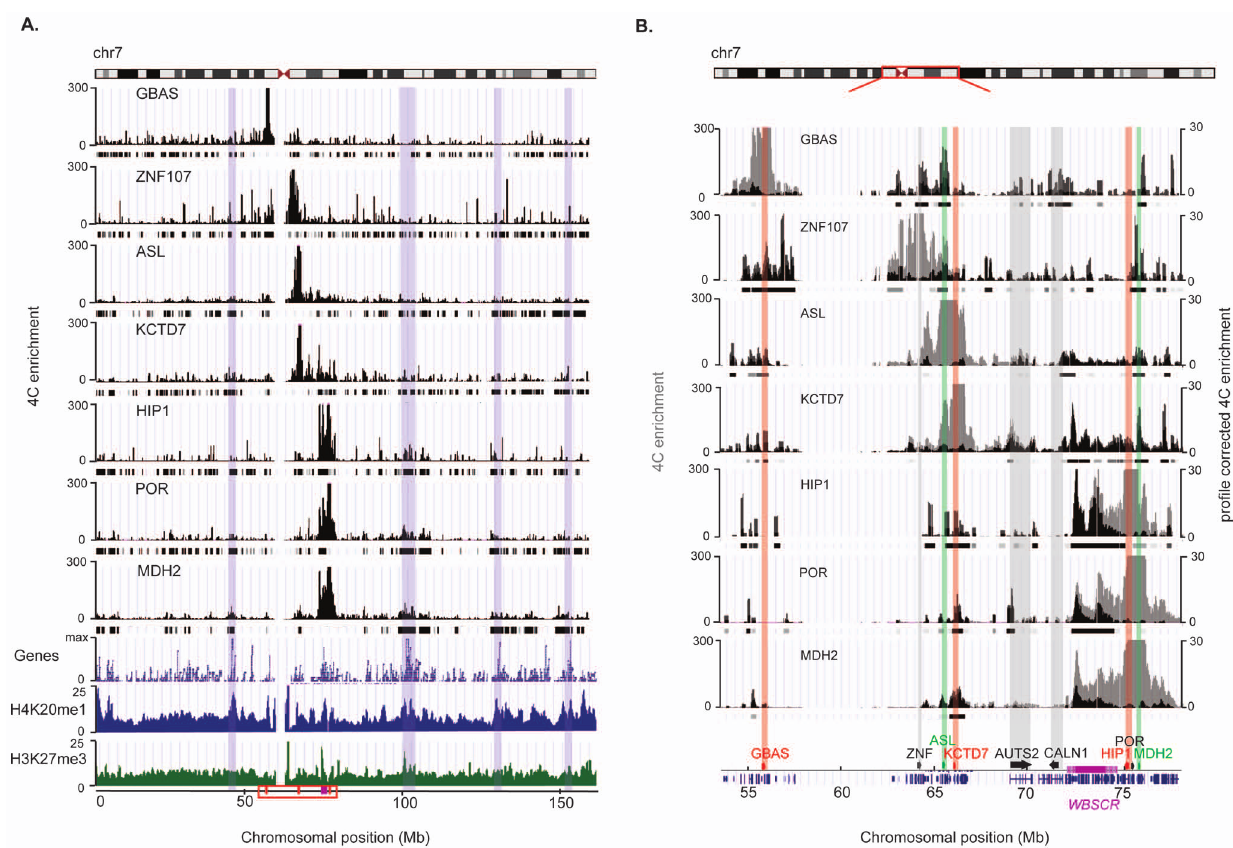
Figure 1. Extensive chromatin interactions of seven genes flanking the WBSCR on human chromosome 7 (HSA7) in cells from a healthy control individual. ( A ) Windowed and normalized 4C signal of each of the seven viewpoints along the entire HSA7. The black ticks below each graph show the location of the Bricks (Blocks of Regulators In Chromosomal Kontext). The gene density across HSA7, as well as the windowed profiles of H4K20me1 and H3K27me3 marks in the same cell line are shown below. Some examples of strong correlation of gene-dense regions and high density of H4K20me1 marks with highly interacting regions are highlighted in blue. The mapping of the assessed genes/viewpoints and of the WBSCR is indicated at the bottom. The red box specifies the close-up shown in panel B. ( B ) Close-up of the windowed 4C signal of the seven viewpoints around the WBSCR for the region indicated with a red box on HSA7 (top panel). The windowed 4C signal is shown in grey, while the profile corrected 4C signal (after removal of the highly interacting neighboring background signal) is overlaid in black. The position of all genes are displayed at the bottom, and the mapping of the assessed viewpoints is highlighted by red and green arrows indicating if the corresponding genes are down- or upregulated in cells from WBS patients, respectively. Black arrows underscore the mapping of the viewpoint that is not modified in gene expression ( ZNF107 ) and the newly identified interacting partners AUTS2 and CALN1 . The location of the WBSCR is indicated by a purple horizontal bar. A close-up of interactions within this WBSCR is provided in Supplementary Figure S4